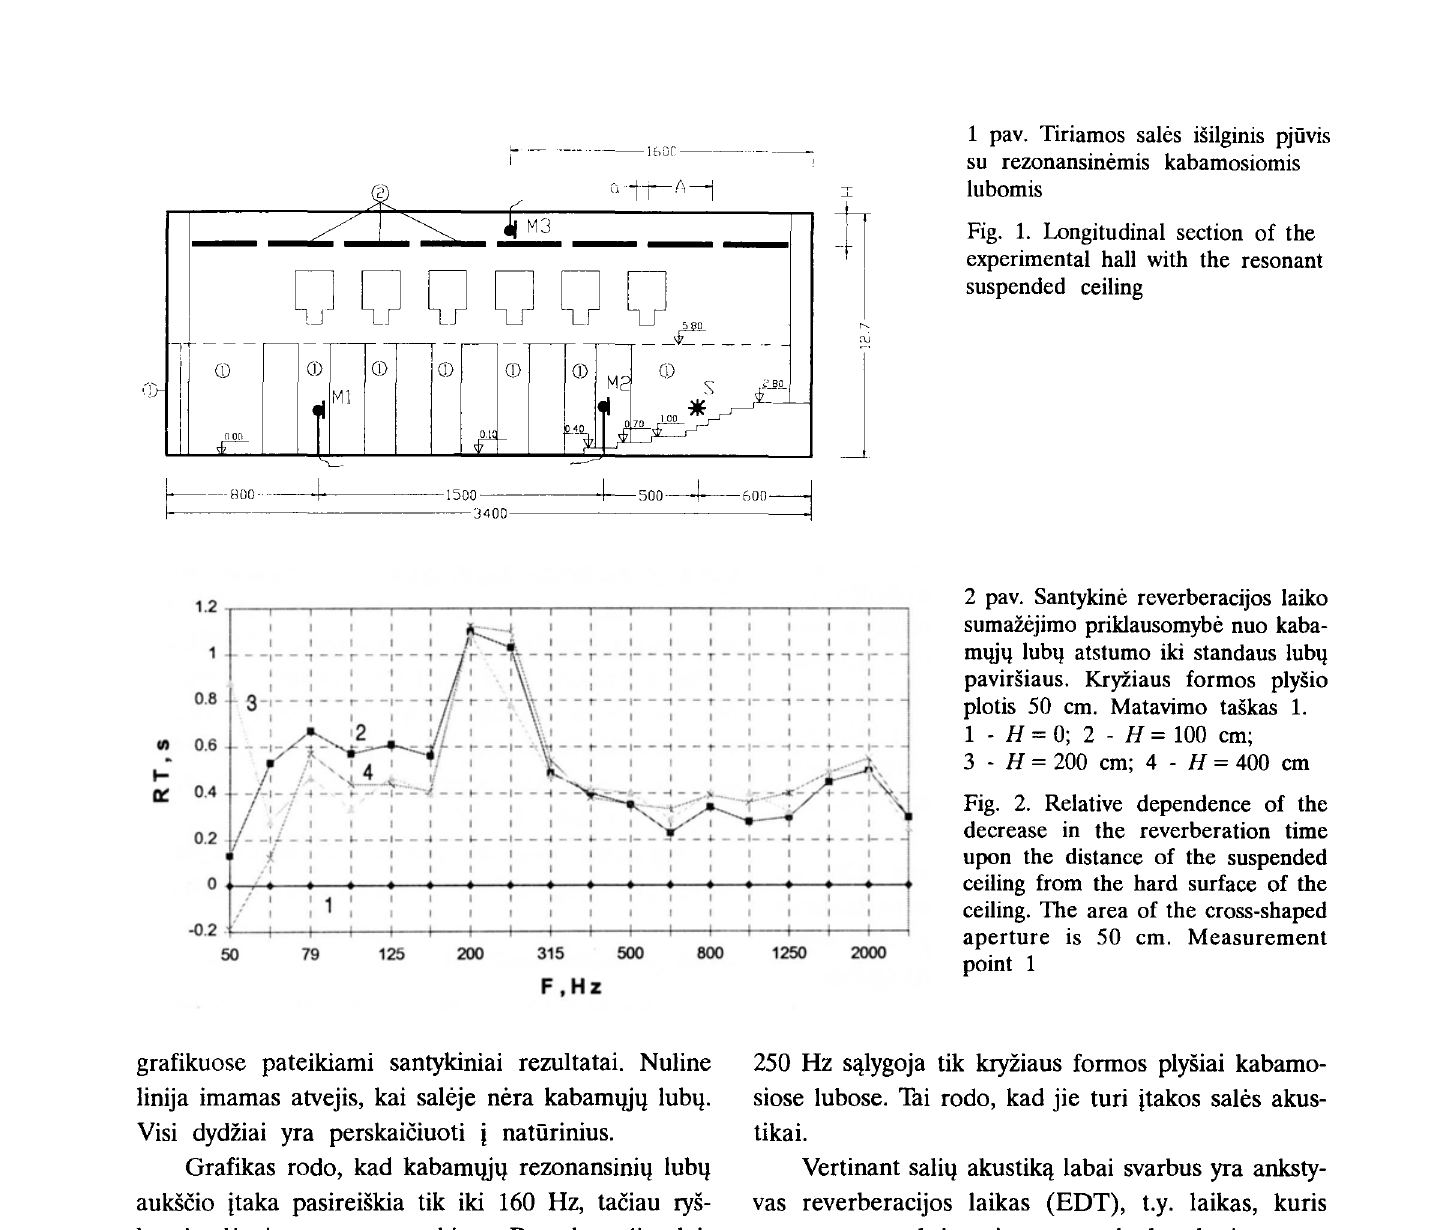
Fig. 1. Longitudinal section of the experimental hall with the resonant suspended ceiling